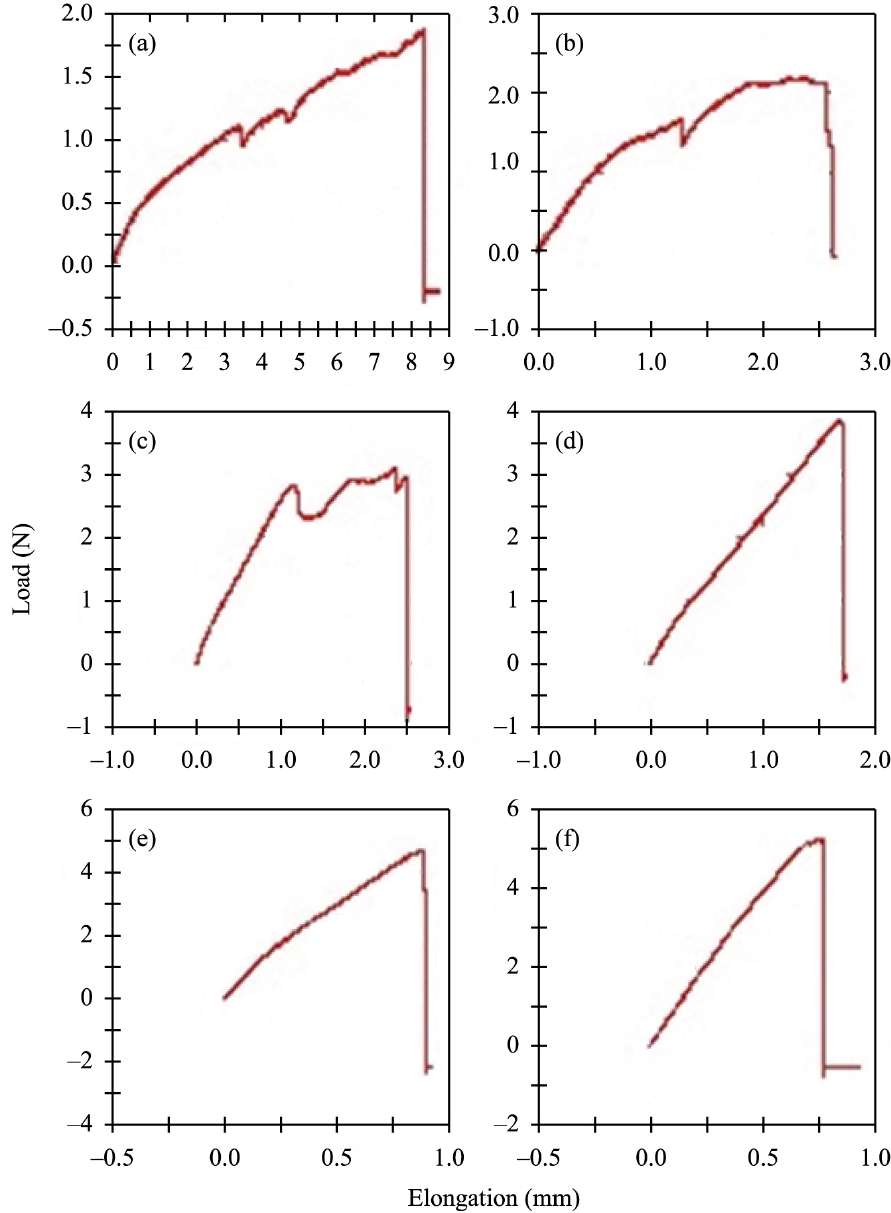
Figure 5. Typical PALF tensile load versus elongation for the different equivalent diameter intervals: (a) 0.10-0.13; (b) 0.13-0.16; (c) 0.16-0.19; (d) 0.19-0.22; (e) 0.22-0.25; (f) 0.25-0.28